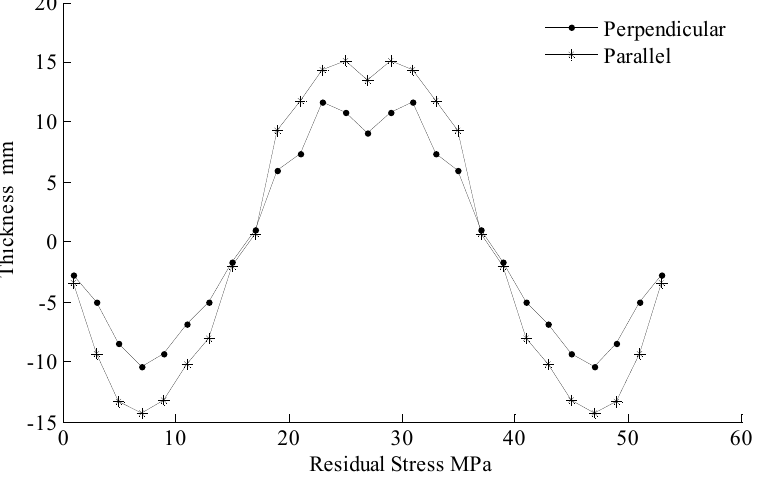
Figure 4. M-symmetric distribution law of initial residual Figure 4. M ‐ symmetric distribution law of initial residual stress.